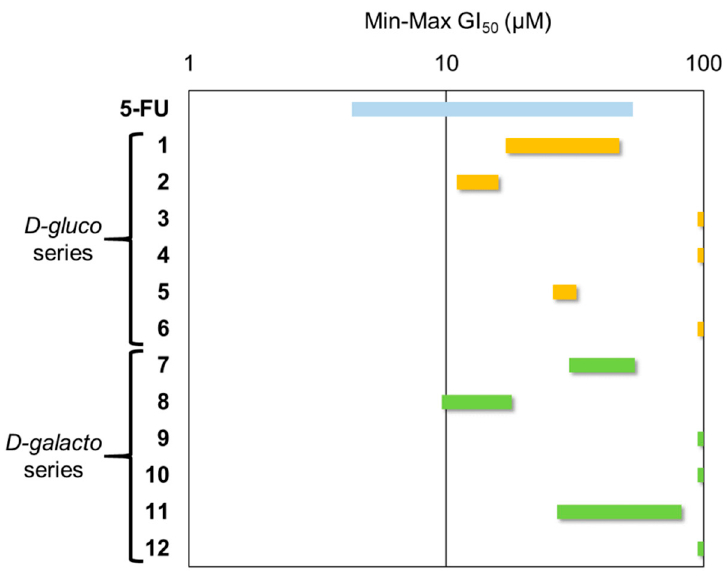
Figure 3. GI 50 range plot of tested compounds. 5-Fluorouracil (5-FU) was used as reference drug.